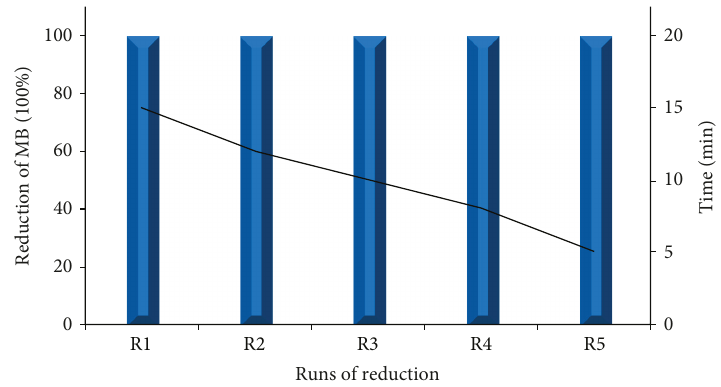
Figure 6: Reusability of CPUF for 100% reduction of MB. R1 represents fi rst run, R2 is for second run, and so on. Primary y -axis shows reduction of MB (%) and secondary y -axis shows time (min) required for 100% reduction of MB in each respective